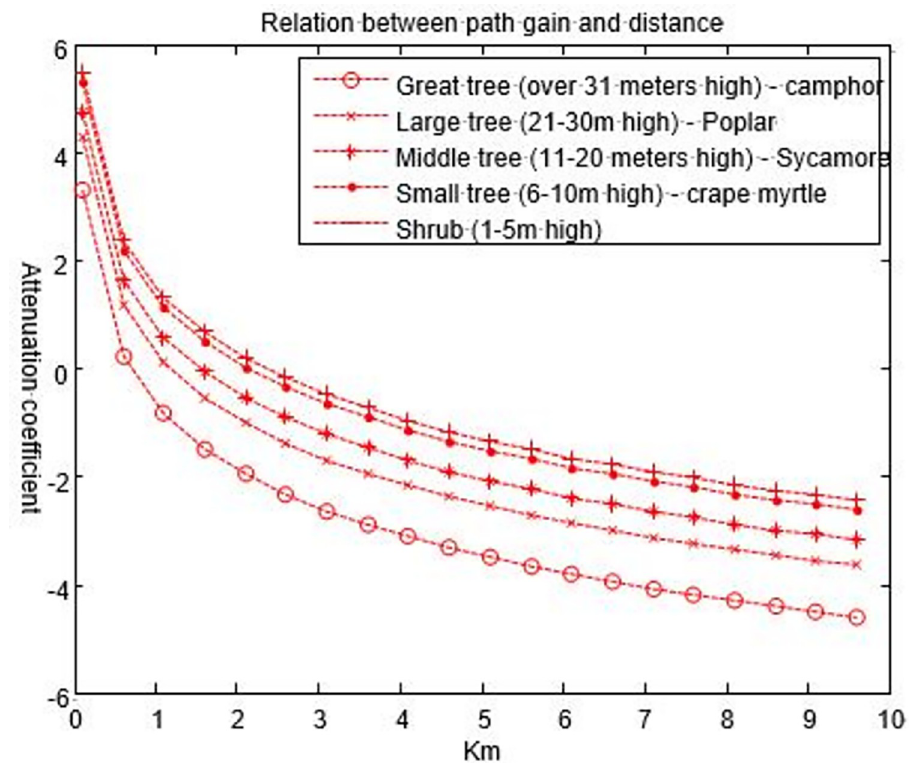
Fig 12. Relationship between the path gain of electromagnetic waves through different vegetations and